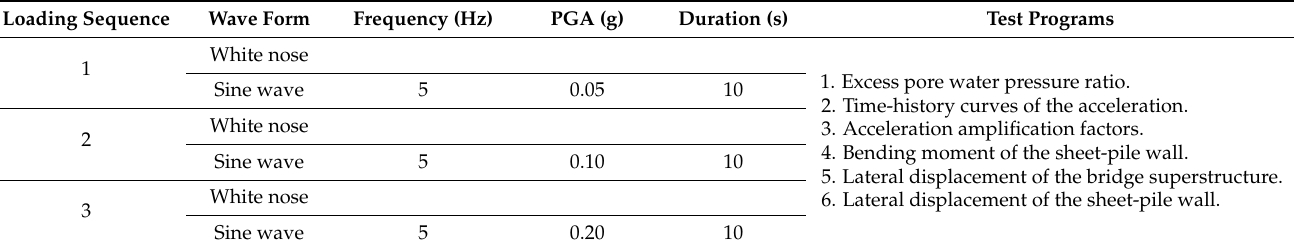
Table 5. Loading sequence and test programs of the model